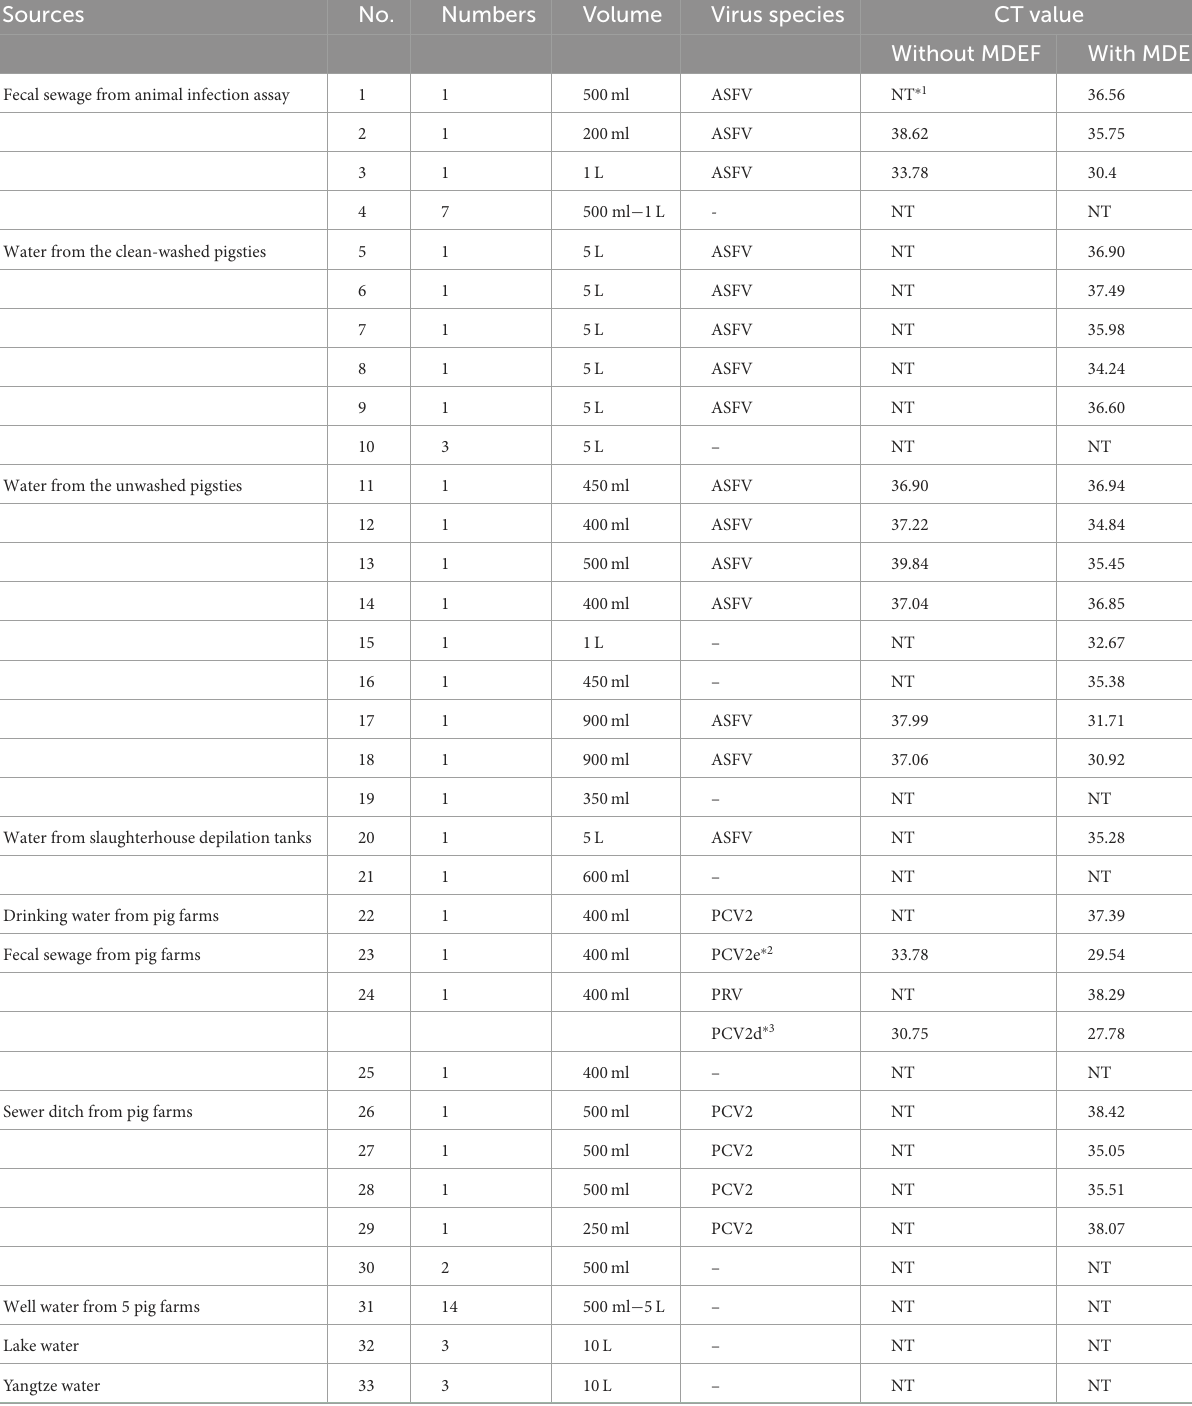
TABLE 2 The MDEF system was applied to 59 samples of natural water or sewage.